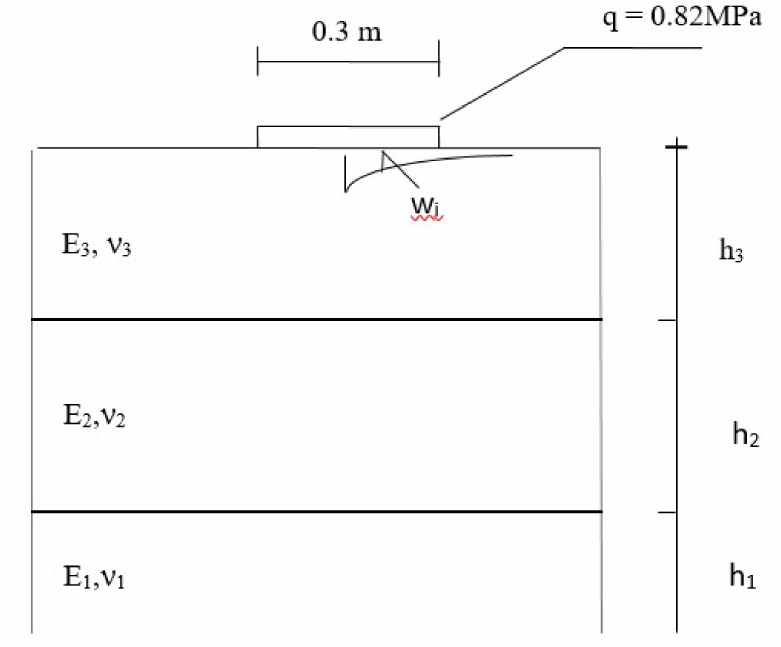
Figure 14. Calculation model of the tested pavement structure.